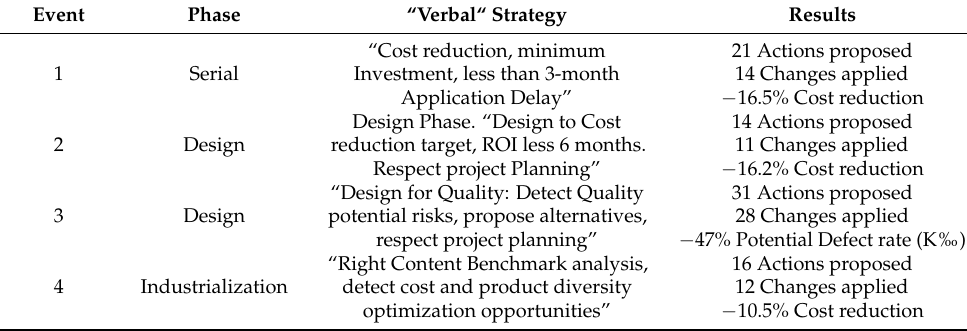
Table 12. First 4 applications events, strategies, and results of the methodology.